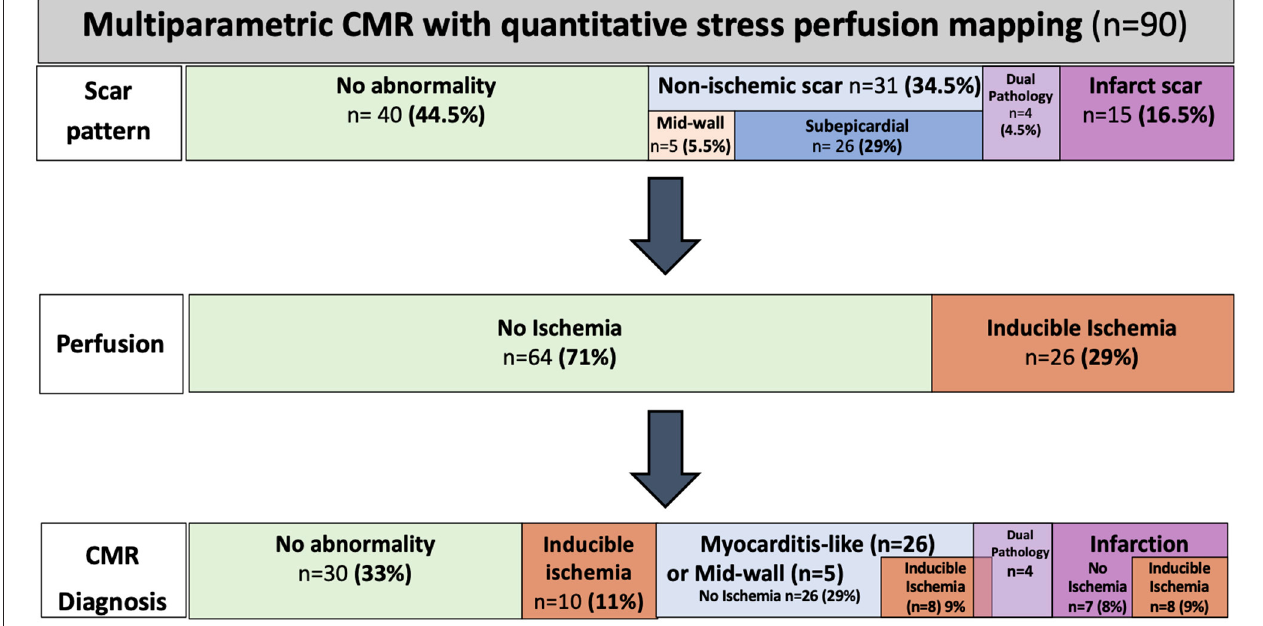
FIGURE 2 | Cardiovascular magnetic resonance (CMR) findings and diagnosis by perfusion CMR. The CMR scar patterns, prevalence of ischemia, and diagnosis across the COVID-19 cohort.